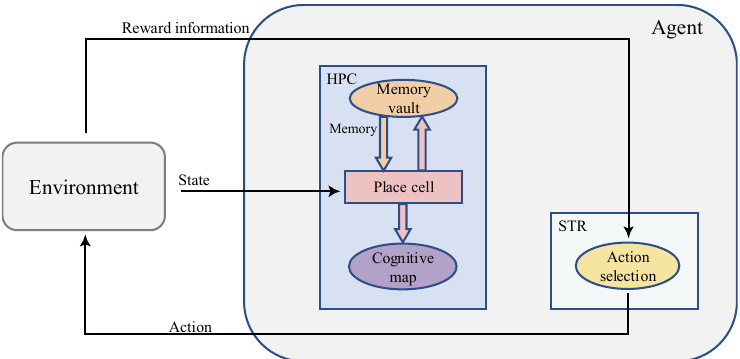
Figure 1. An overall schematic of the model. The square structures represent the anatomical structures that actually exist in the brain, and the oval structures represent the functional structures.